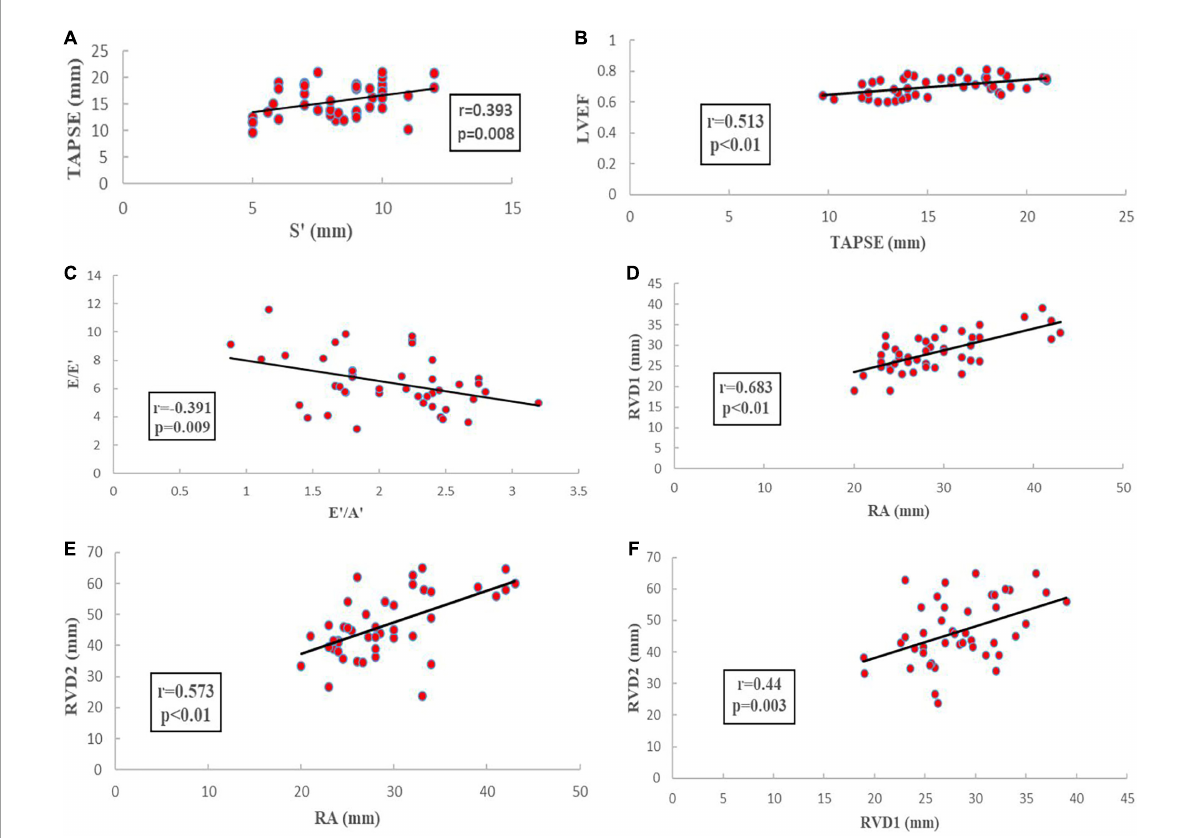
TABLE 8 The conditions of tricuspid and pulmonary valve regurgitation.